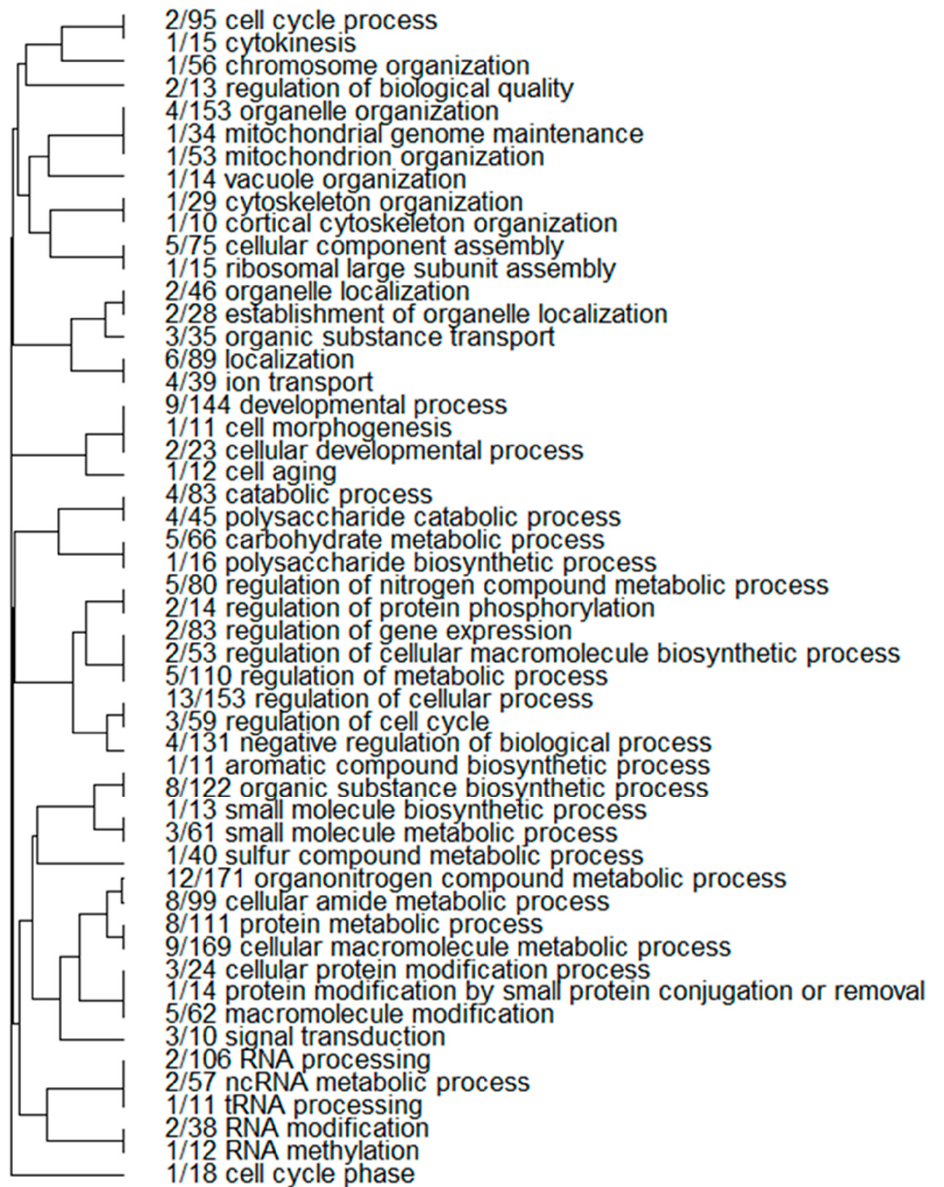
Figure 3. Predicted endogenous target clustering of the selected V. nonalfalfae gene models by their biological process according to enriched gene ontologies; the values represent the number of selected milRNA targets in each enriched GO